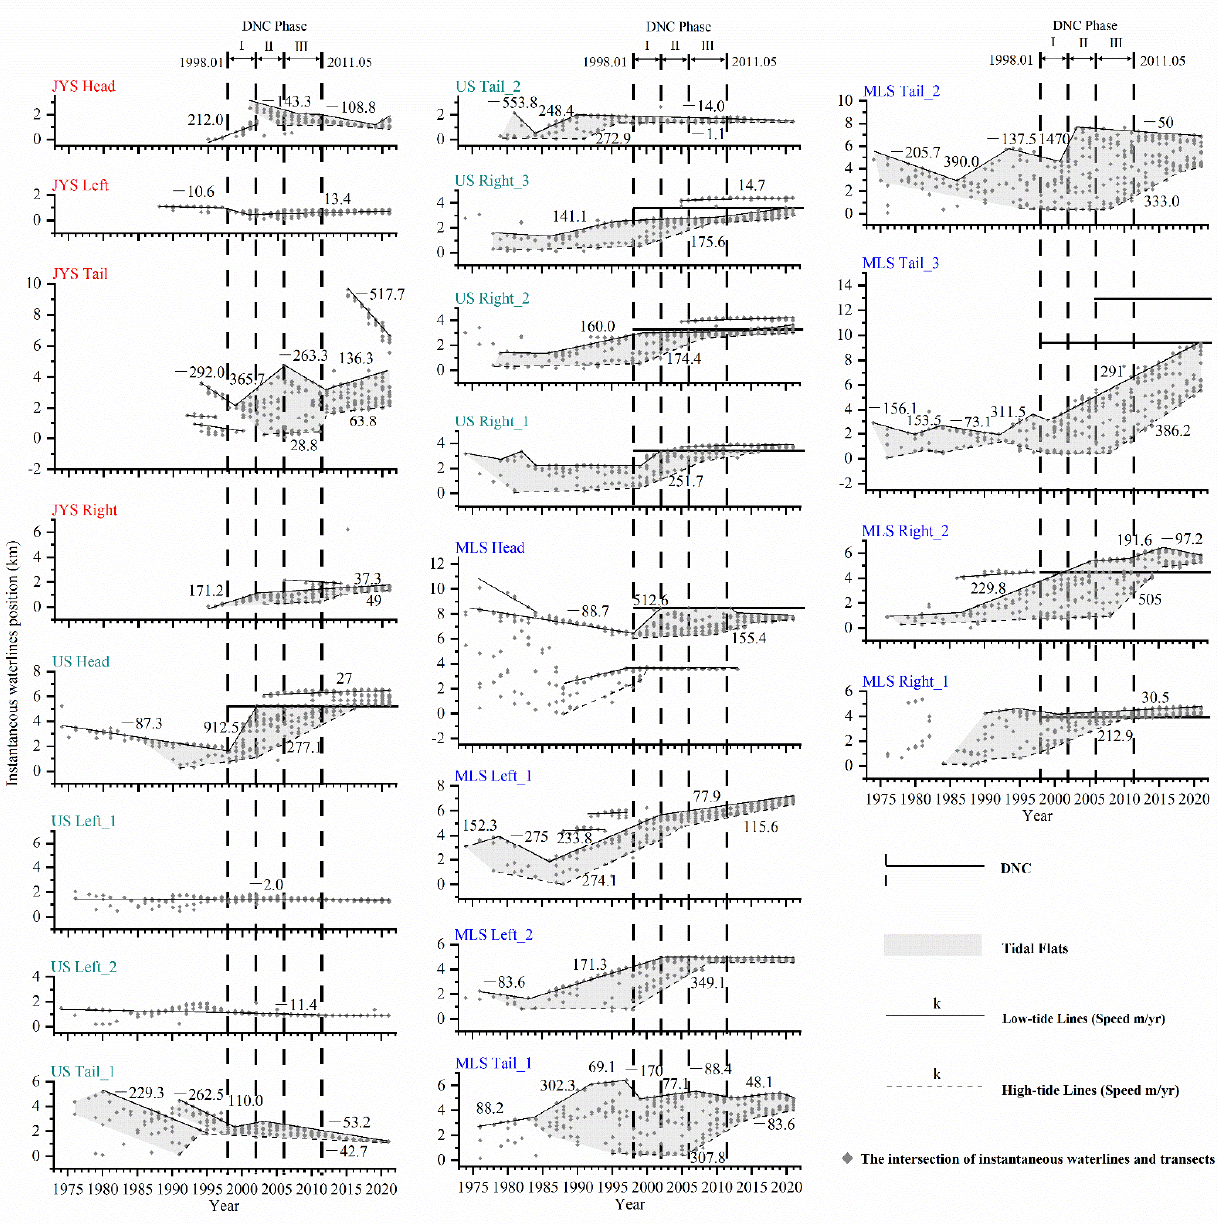
Figure 4. Positional change of the instantaneous waterlines in each shoal of the JDS along the transects during 1973–2021.